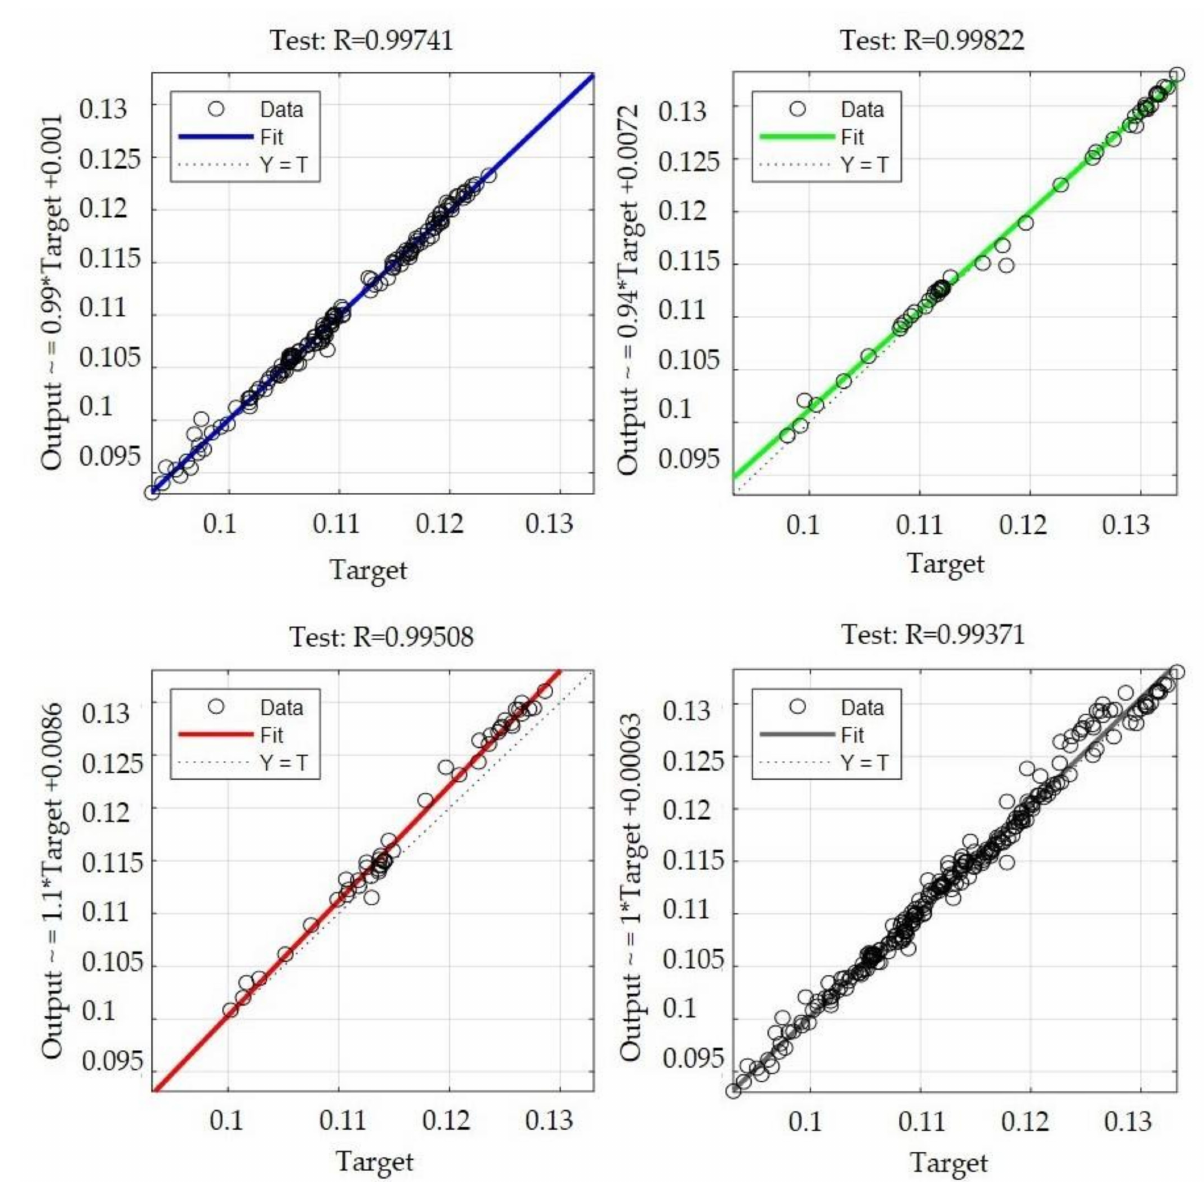
Figure 7. Statistical data for the training process of the ANN for temperature field prediction at specific